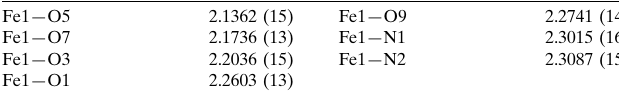
Selected bond lengths (A˚ ).